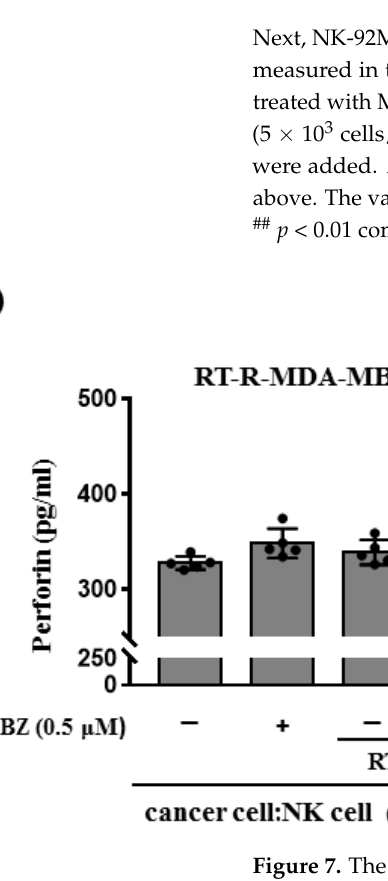
Figure 7. The combination of mebendazole (MBZ) and radiotherapy (RT) more efficiently induces perforin and granzyme B production by NK cells compared to RT. RT-resistant (RT-R)-MDA-MB-231 cells were treated with MBZ (0.5 µ M) for 1 h and then irradiated with a 3 Gy dose of X-rays. After 24 h, the cells were seeded in a round-bottom 96-well plate, and NK-92MI cells (1:10 ratio) were added. After co-incubation for 4 h, ( A ) perforin and ( B ) granzyme B were measured in cell supernatants as described in the manufacturer’s protocol. The values are presented as the mean ± SD (* p < 0.05, ** p < 0.01 compared with the control; ## p < 0.01 compared with the control of RT; $$ p < 0.01 compared with MBZ).